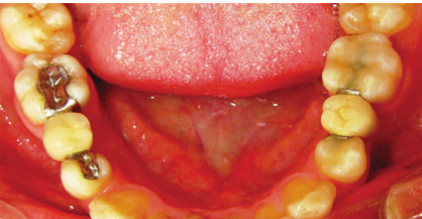
Figure 4: Intraoral occlusal view of the two metal-ceramic IRFDPs after 1-year follow-up time: (left) the modified design and (right) the traditional